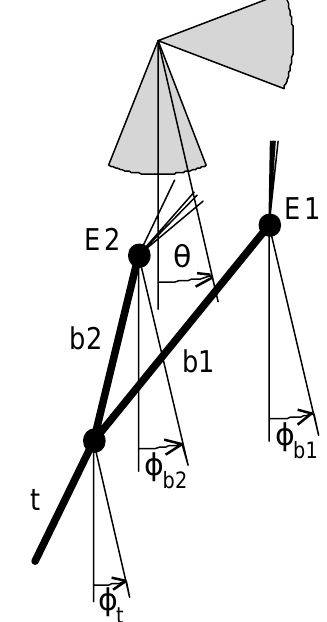
FIG. 9. Optimum direction of the transport line and extraction branches. Optimization was performed for the extraction with two exit points. Positive ion beams with 2.08 # K # 2.67 are extracted through the exit point E 1 whose u E 1 (cid:1) 31 ± . Negative ion beams of H and D, and positive ion beams with K (cid:1) 2.00 and K $ 3.00 are extracted through the exit point E 2 whose u E 2 (cid:1) 2 5 ± . Short thin lines passing through an exit point depict incoming test beam directions. Thick lines represent optimum directions of the two extraction branches and transport line. It was assumed that the two extraction branches cross at R (cid:1) 3 m. Optimum beam transport directions require the narrowest range of the bending magnetic field. Obtained values of the first and second extraction branch direction and transport line direction are w The expected maximum required bending magnetic field is ap- proximately 0.5 (cid:1) L m T, where L M is the length of the bending magnet in